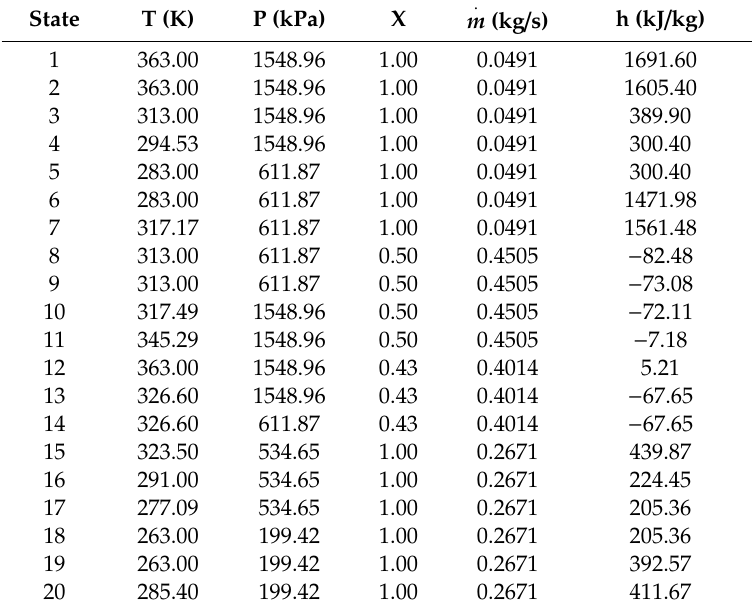
Table 4. Thermodynamic data of the compression–absorption cascade system using NH 3 -NaSCN solution and R134a as working fluid.